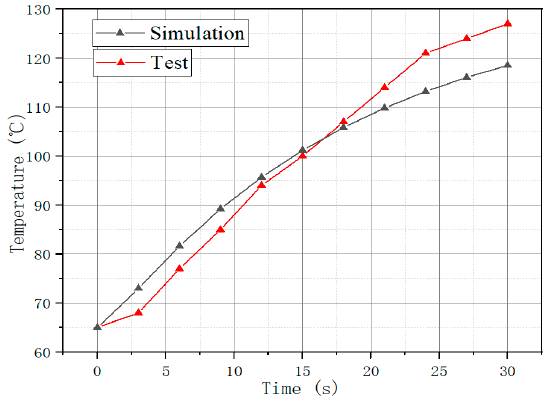
Figure 10. Temperature comparison between simulation and prototype test.